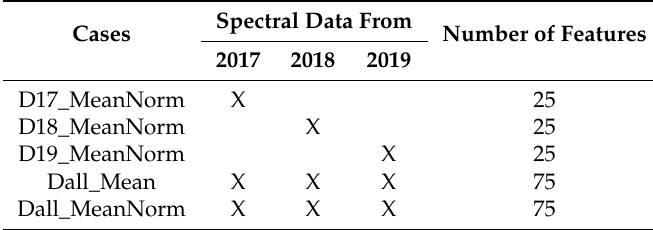
Table 5. The number of features used in each